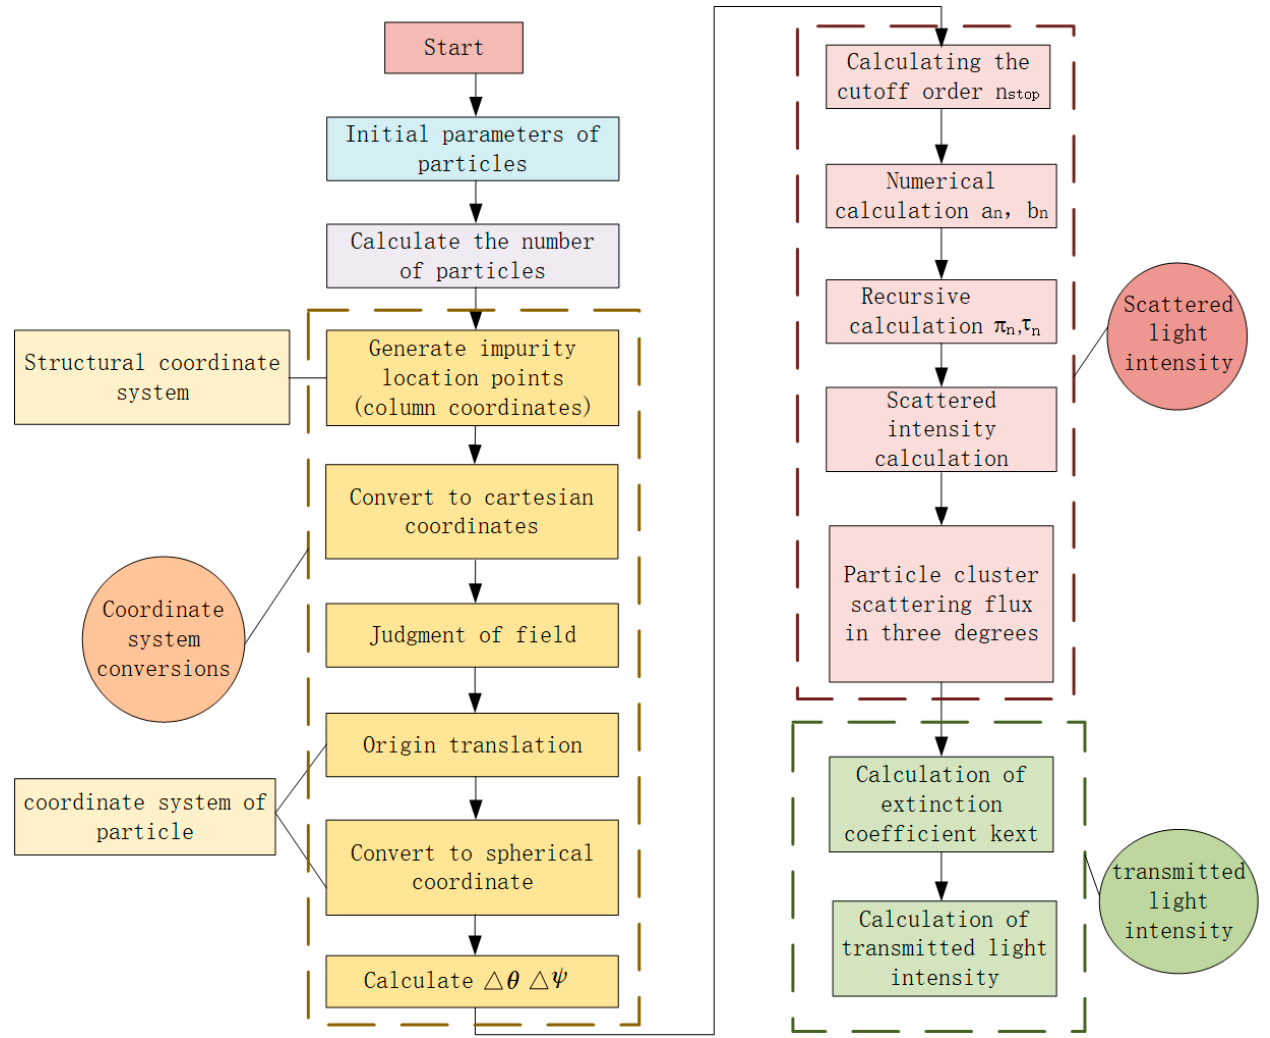
Figure 3. Simulation flow chart.